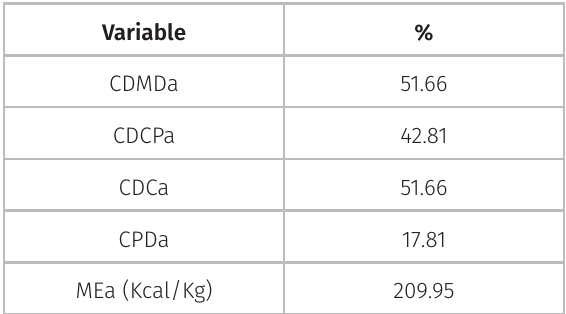
Table III. Coefficient of apparent dry matter digestibility (CDMDa), coefficient of apparent digestibility of crude protein (CDCPa), coefficient of apparent digestibility of calcium (CDCa), coefficient of apparent phosphorus digestibility (CPDa) and apparent metabolizable energy